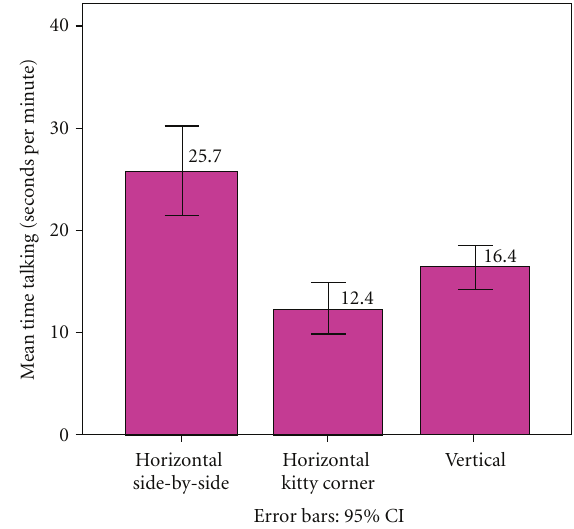
Figure 3: Average looks per minute (per person).